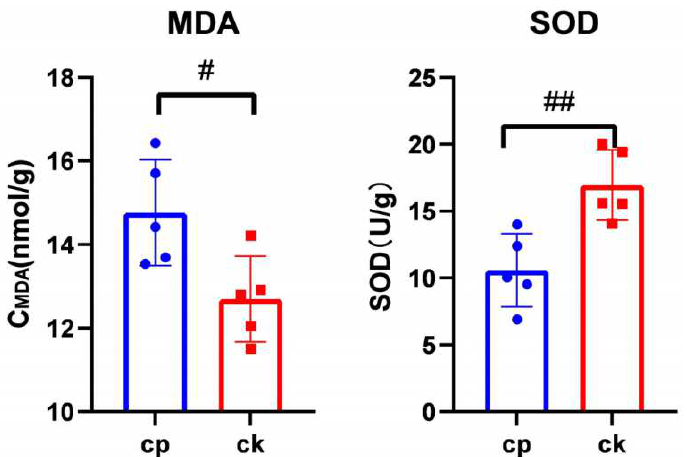
Figure 8. Colorimetric determination of MDA and SOD concentrations in rat placenta ( n = 5). Each data point represents the mean ± S.E.M. # p < 0.05 and ## p < 0.01 versus CK.